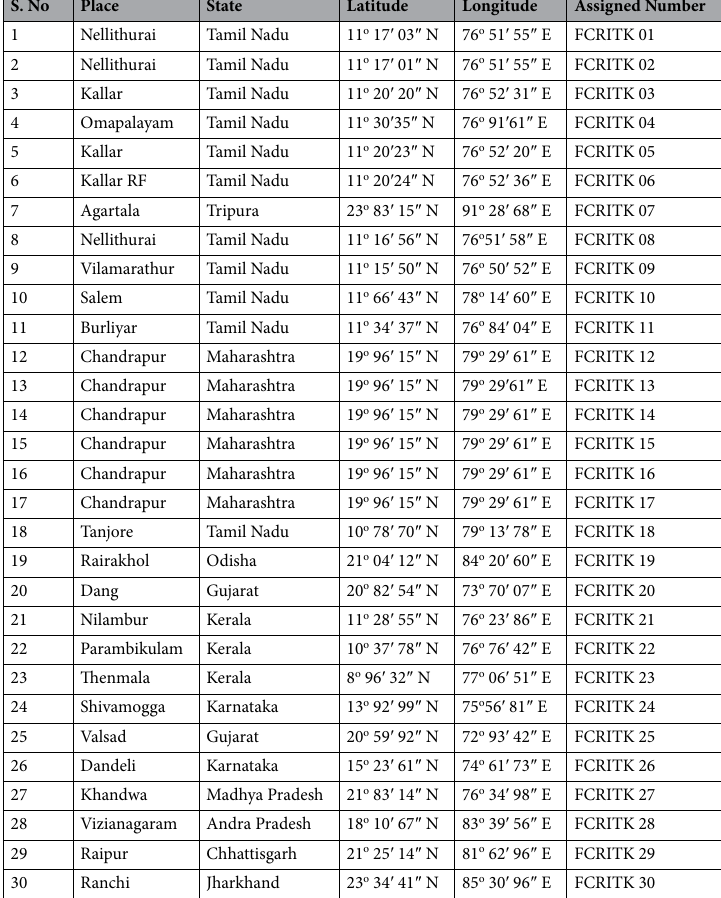
Table 1. Source details of thirty teak seed sources investigated in the study with their geographical